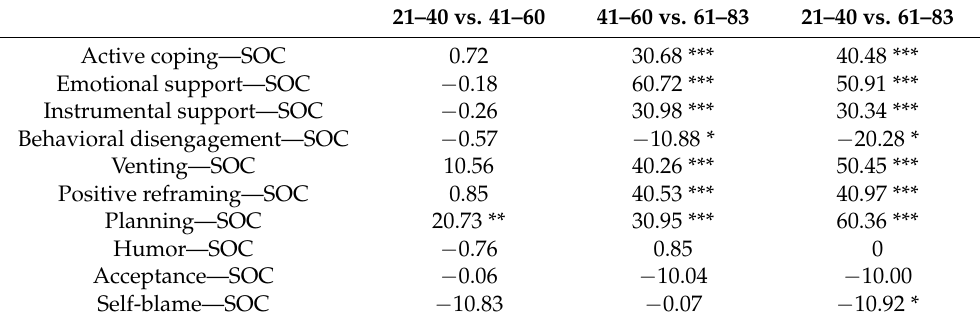
Table 3. Differences in the strengths of the correlations in the different age groups, as represented by z